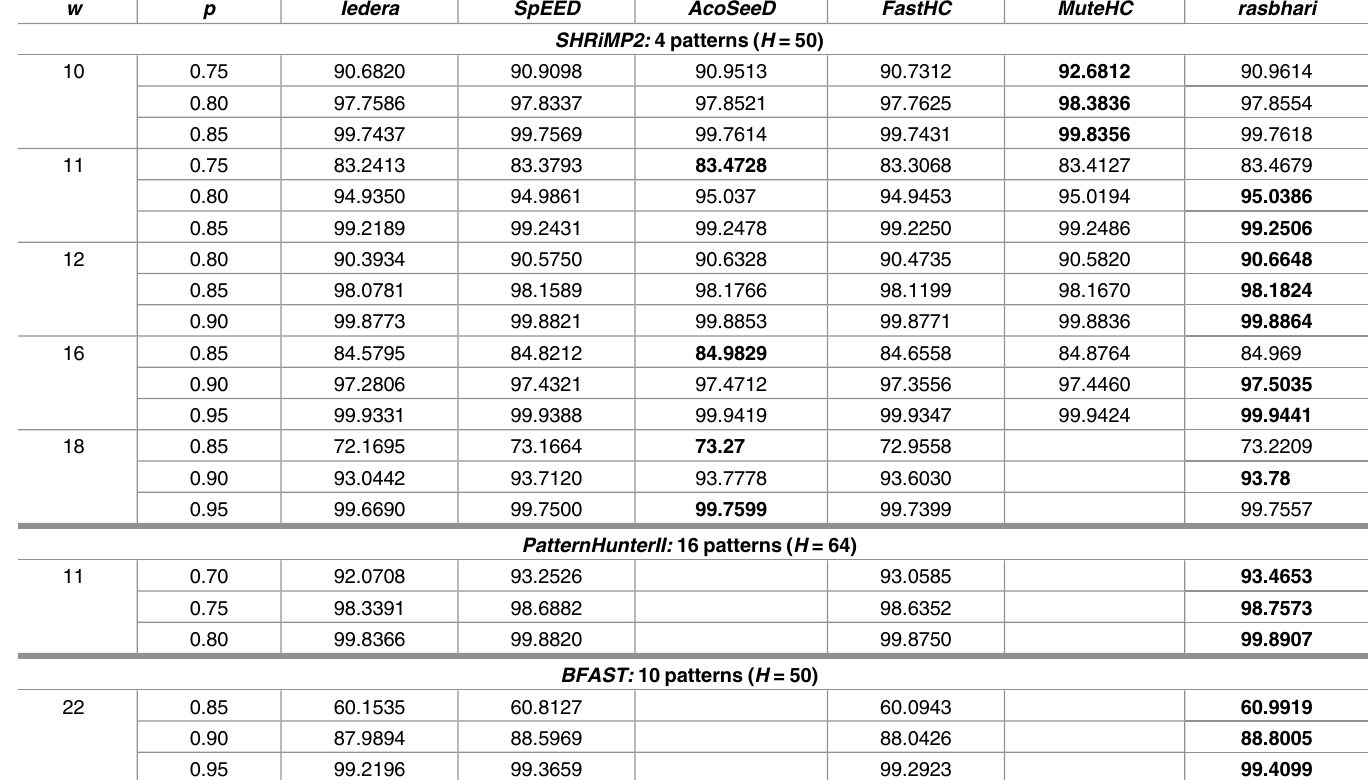
Table 1. Sensitivity comparison of different